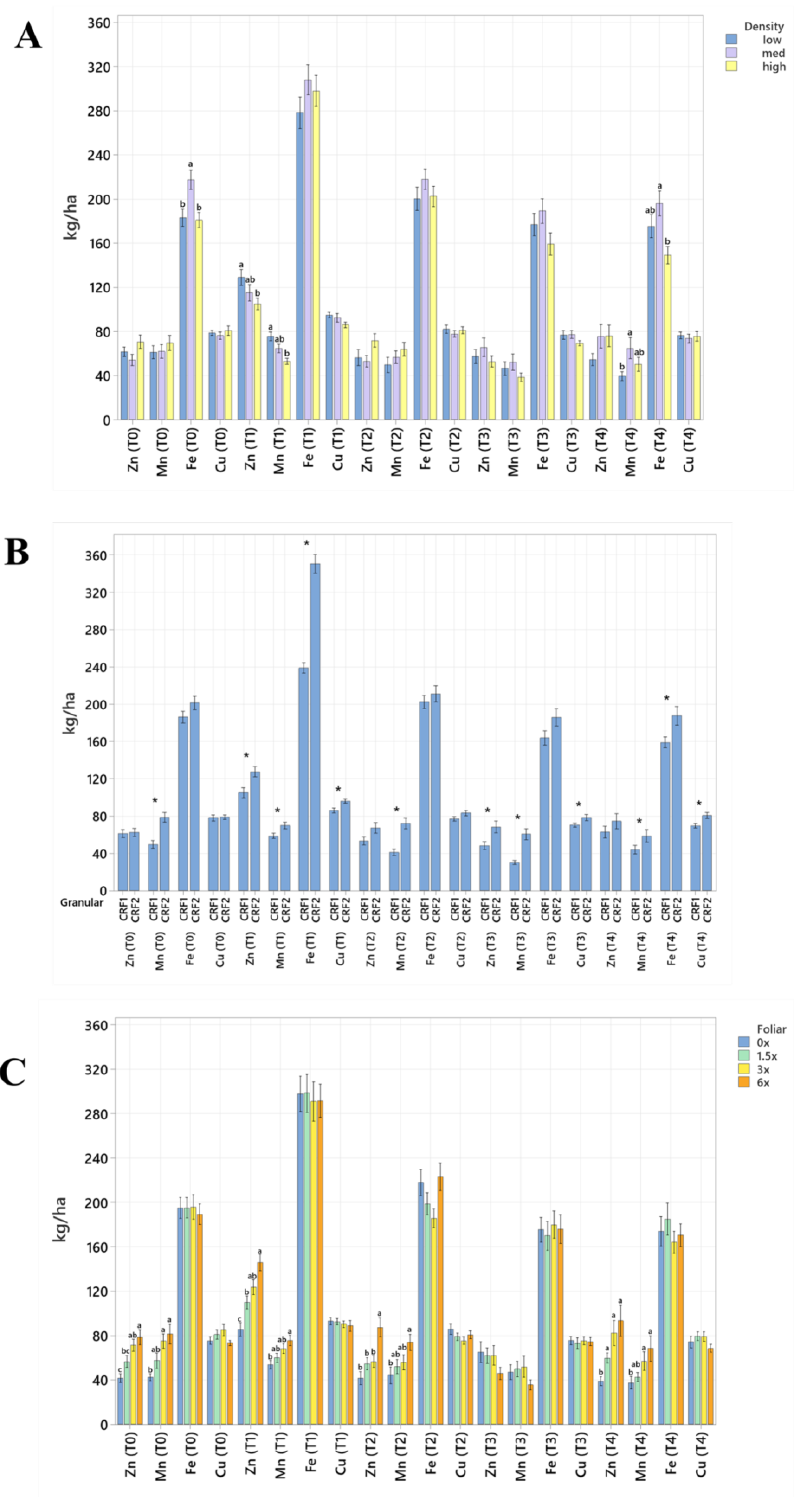
Figure 3. Soil micronutrient concentrations of ‘Ray Ruby’ grapefruit grafted on ‘Kuharske’ citrange planted in flatwood soils located in Fort Pierce, FL, USA, in response to ( A ) planting density, ( B ) ground-applied fertilizer and ( C ) foliar fertilizer treatments during September 2020 (T0), January 2021 (T1), May 2021 (T2), September 2021 (T3) and January 2022 (T4). Bars are ± standard deviation of the mean. Treatments with * and different letters were considered to be significantly different ( p <